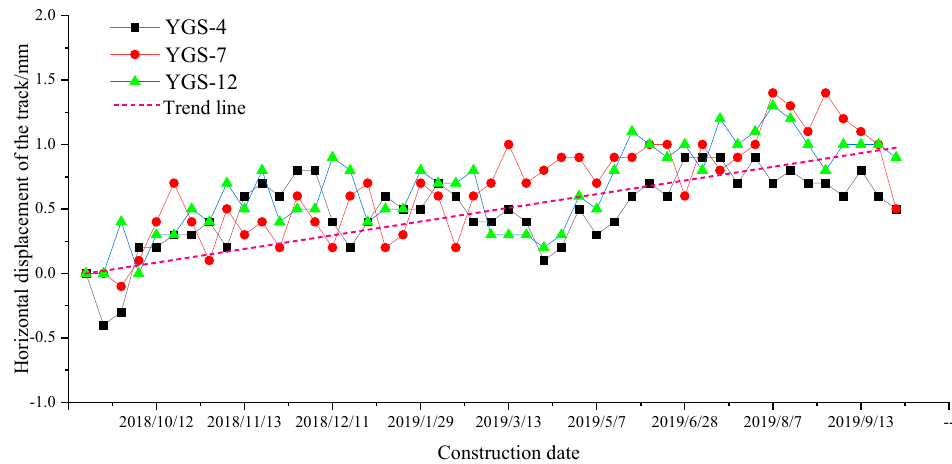
Figure 15. Horizontal displacement time − history curve of the right track. In the process of foundation pit excavation, by extracting the vertical displacement data of the left and right tracks and subtracting the left and right rail data, the horizontal time-history changes of the left and right rails are obtained. As shown in Figures 16 and 17, the horizontal deviation of the right rail is between − 0.8 and 0.6 mm, and the maximum deviation occurs in the fourth excavation stage of the foundation pit (that is, the excavation depth is 20.5 m), which is located at the position of the YGD-8 measuring point (that is, the middle of the right rail). The horizontal deviation of the left rail is − 0.4 to 0.6 mm, and the maximum horizontal deviation occurs in the fifth excavation stage of the foundation pit (that is, the excavation depth of the foundation pit is 25.5 m), which is located at the ZGD-4 measuring point (that is, the middle of the left rail). Through the analysis of the manual monitoring data of the track distance of the left and right lines, the maximum deviation value of the track distance in the construction process is +2 mm, less than the deformation control requirements, which meets the allowable deformation control requirements of the track geometry. In the process of foundation pit construction, the deformation control of the track structure is better, and the safe operation of subway trains is not affected in the process of foundation pit construction.